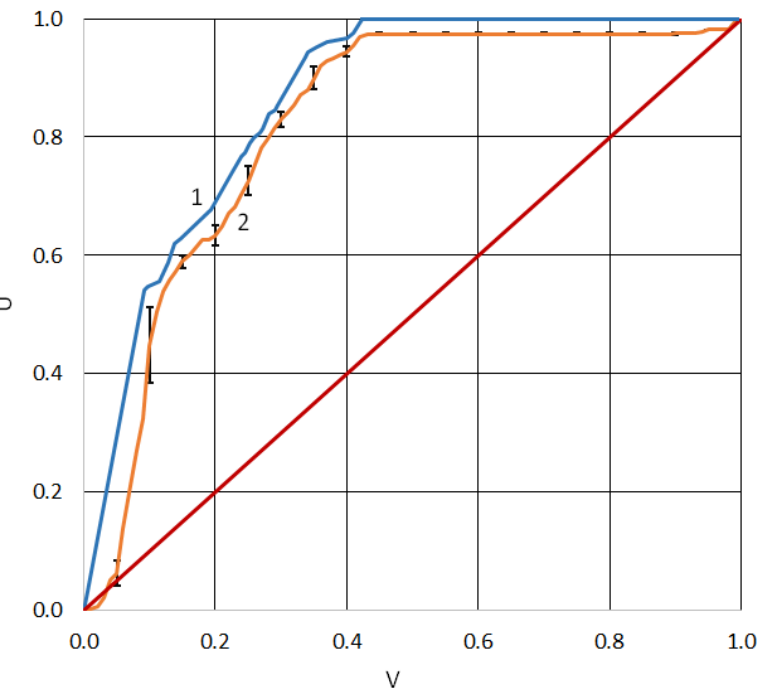
Figure 3. Dependences of the probability of successful classification of patients with indolent prostate cancer (PCa) U on the probability of misclassification of patients with an aggressive form of the disease V . 1—dependence U ( V ) when testing on a training sample; 2—dependence U ( V ) obtained by 10-fold cross-validation; vertical segments define the values of standard